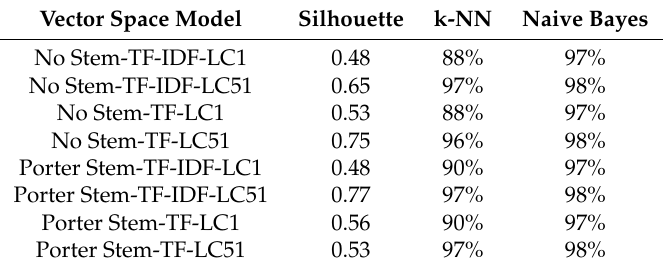
Table 2. Silhouette coefficient computed for each projection presented in Figure 6 and the classification rate from the k-NN and naive Bayes classifiers: vector space models from the NEWS-8